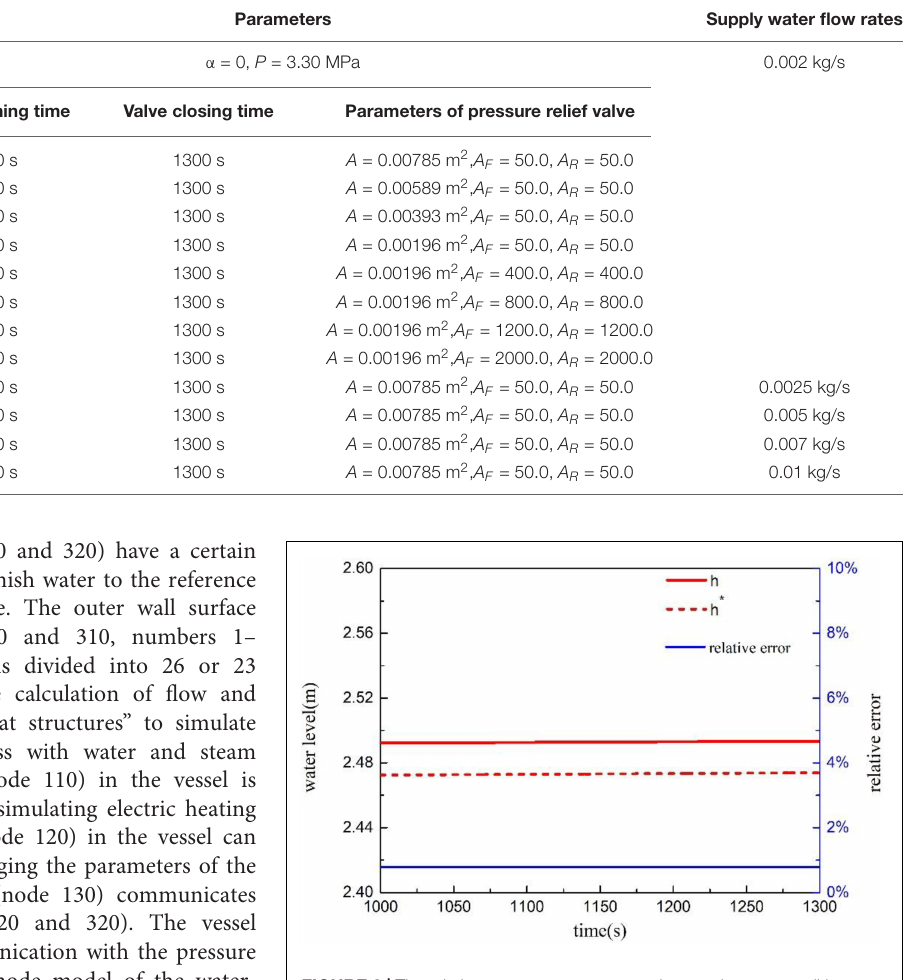
2.49 m, the measured value of the water-level meter is stable at 2.47 m, the measured value is always smaller than the real level, and the relative error is basically stable at